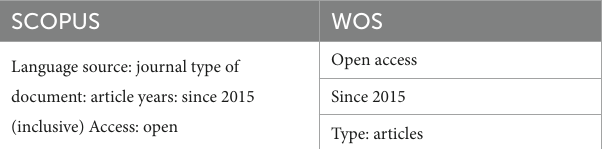
TABLE 2 Filters used in the systematic